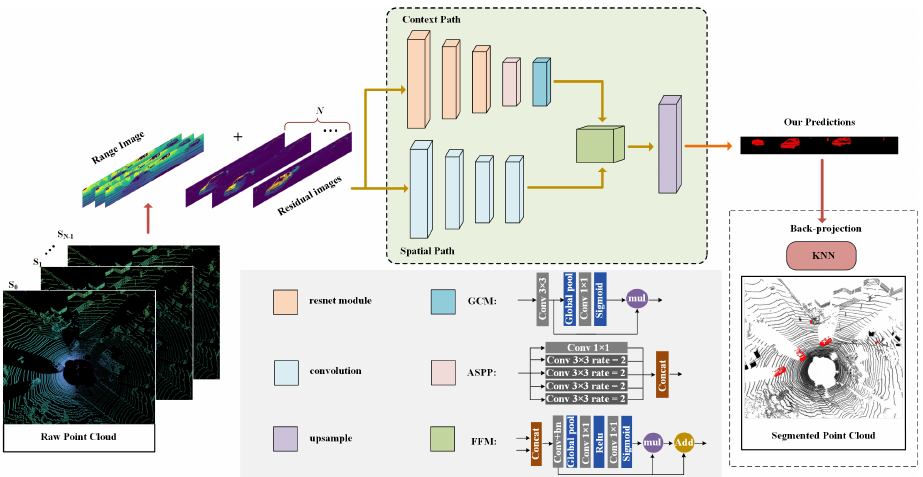
Figure 2. Architecture of the proposed CNN for point-cloud moving object